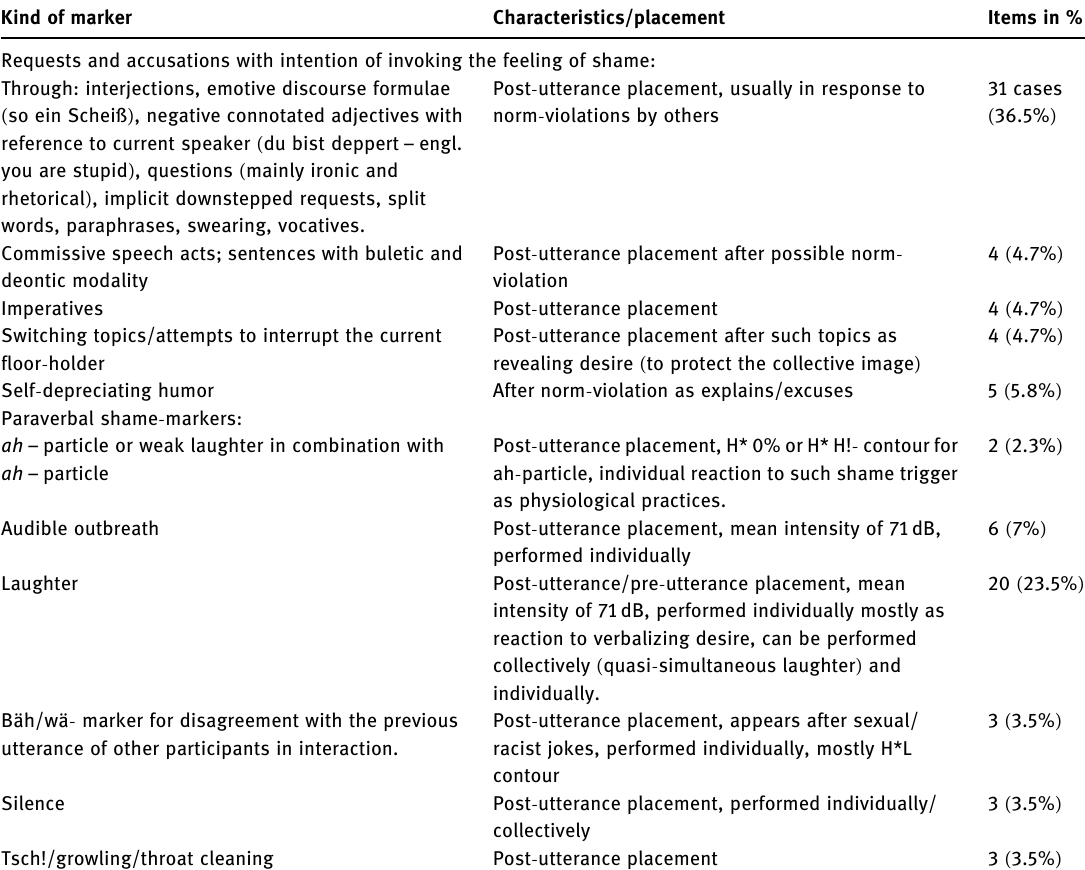
Table 5: Overview of embarrassment - displays in Austrian data Kind of marker Characteristics/placement Items in % Requests and accusations with intention of invoking the feeling of